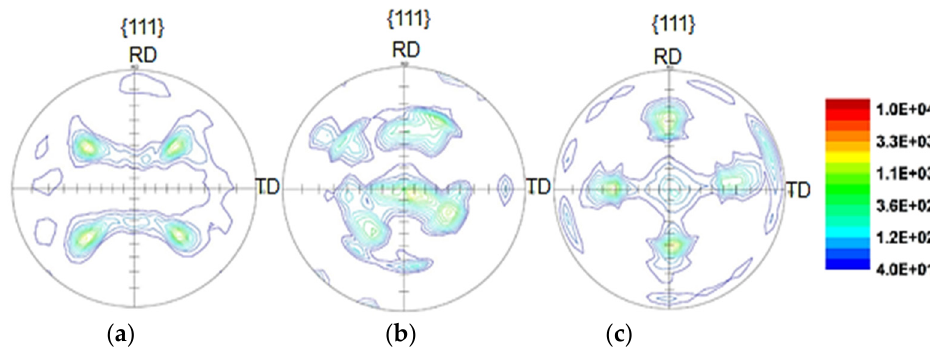
Figure 8. Pole figures of {111} selected plane for: ( a ) Annealed sheet; ( b ) ARBed sample after the first cycle; ( c ) ARBed sample after the fifth cycle.